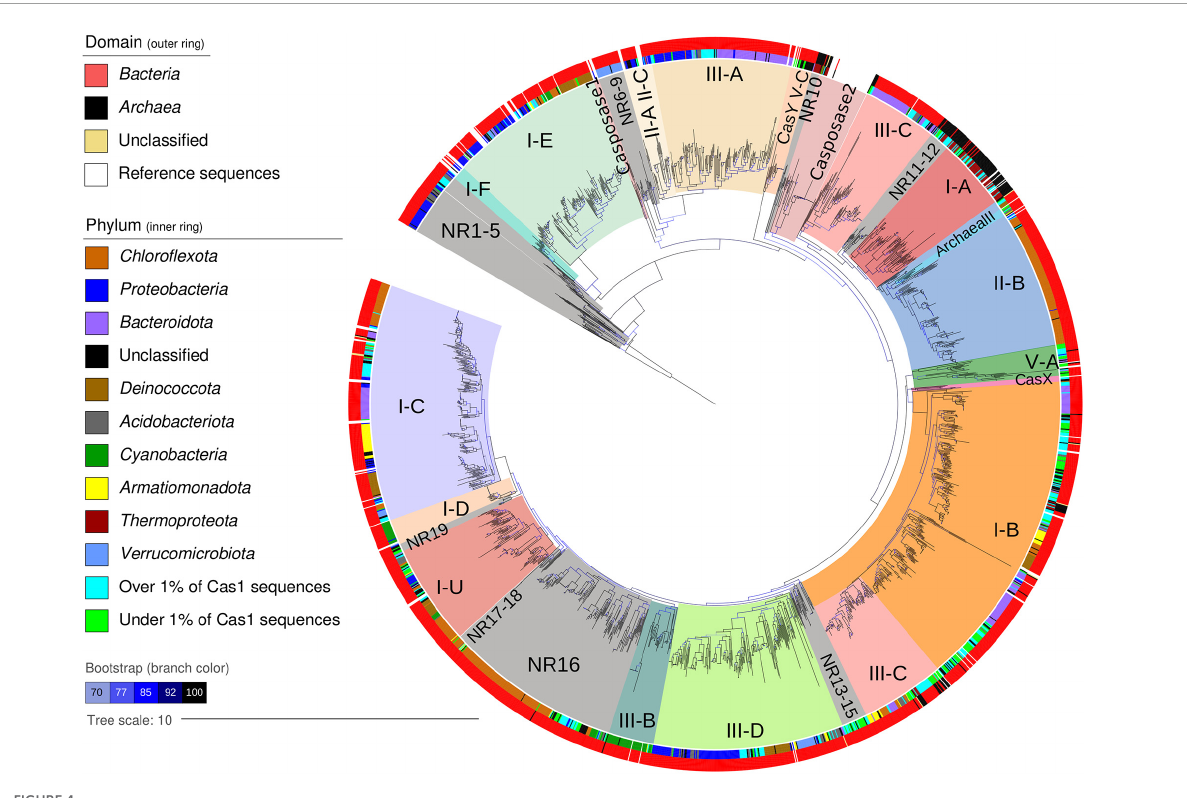
FIGURE4 Maximum-likelihood phylogenetic tree of 2,150 Cas1 proteins from 48 global hot spring metagenomes. Domain and phylum are indicated as outer and inner rings, respectively, according to the left legend. The remaining taxa over and under 1% of Cas1 sequences are represented by one respective color. Tree clades are colored according to reference Cas1 sequences of a CRISPR-Cas system subtype mentioned by Wu et al. (2020) or casposase genes used in the phylogenetic analyses. Hot spring tree clades without reference are labeled as NR (no reference). Branch color indicates ultrafast bootstrap values (10,000 repetitions) as a percentage, over 70% in all cases. The tree was rooted using the Streptomyces coelicolor transposase gene